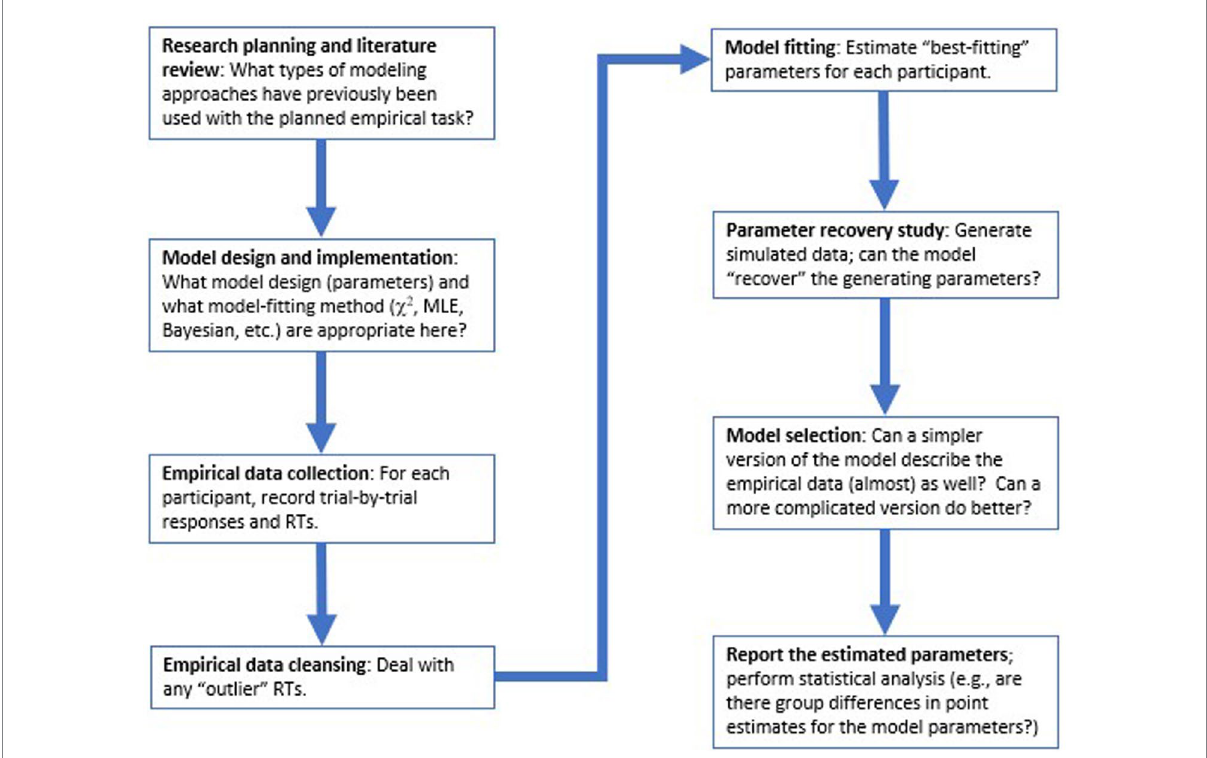
FIGURE 1 Overview of key steps in the modeling process. Typically, choices relating to model design and implementation should be made at task design stage, before collection of empirical data. Then, after data collection and data cleansing, model-fitting is conducted to estimate “best-fitting” parameters for each participant that allow the model to most closely replicate that participant’s accuracy and reaction time (RT) distributions, followed by model validation and model selection procedures, before the modeling results are reported and subjected to conventional statistical